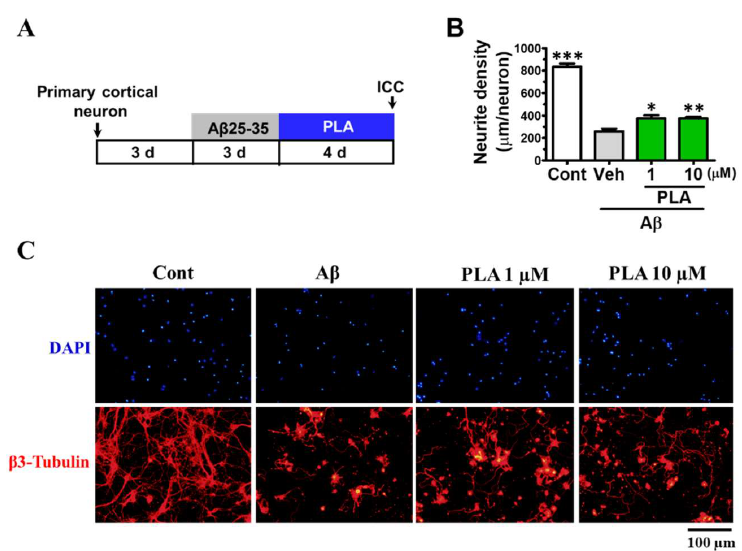
Figure 8. Effects of platycodigenin (PLA) on Aβ25-35-induced neuritic atrophy. Primary cultured cortical neurons were cultured for 3 d and pre-treated with Aβ25-35 (10 μM) for 3 d, then PLA (1 and 10 μM) or control (Cont, 0.1% DMSO) were treated to neurons for another 4 d. The neurons were fixed and immunostained for β3-tubulin. The lengths of the β3-tubulin positive neurites were measured. ( A ) Time course of the experiments. ( B ) Quantification of total neurite outgrowth and associated statistics. ( C ) Representative images of β3-tubulin-positive neurites in Aβ25-35 treated group. Scale bar, 100 μm. The data are shown as the mean ± SEM of three independent experiments. Ten images were captured of each group in the independent experiment. * p < 0.05, ** p < 0.01 and *** p < 0.001